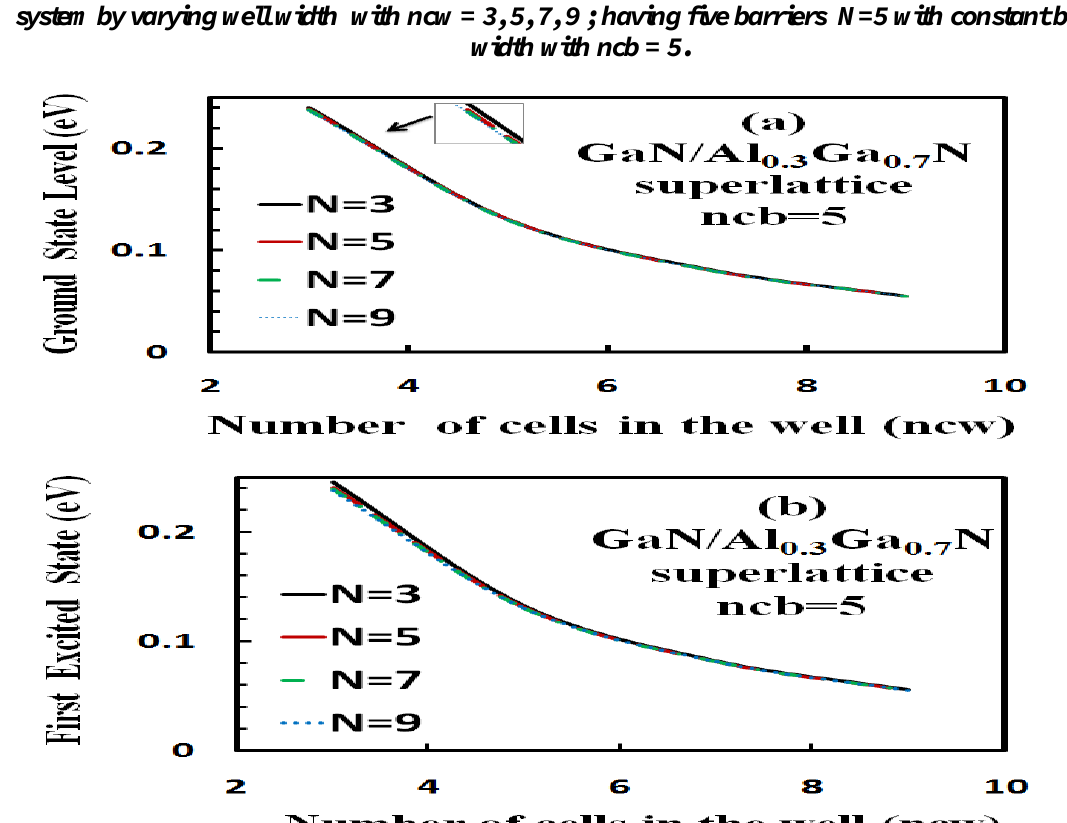
Ga N superlattice 0.3 0.7